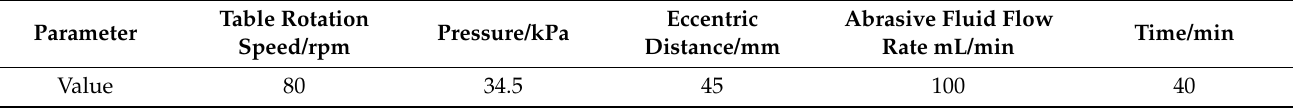
Table 2. Processing parameters of grinding